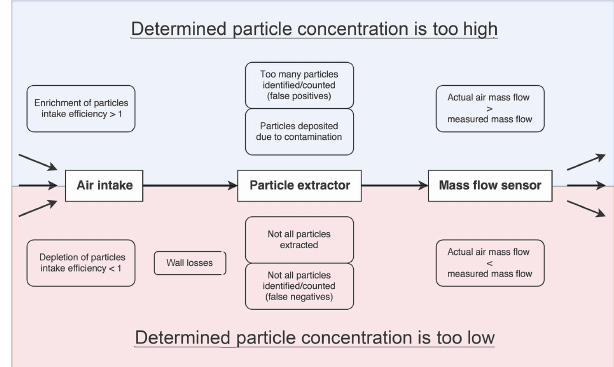
Figure 8. Overview of the possible influences of the different com- ponents of the newly developed particle collection system (PCS) on the final determined particle concentration. The components of the PCS, in which the influences can occur, namely air inlet, impactor, and mass flow sensor, are arranged along the horizontal axis. Influ- ences that can lead to the determination of a particle concentration higher than the actual particle concentration are shown in the up- per half of the figure (blue background), whereas the influences that can lead to the determination of a particle concentration lower than the actual particle concentration are shown in the lower half of the figure (red